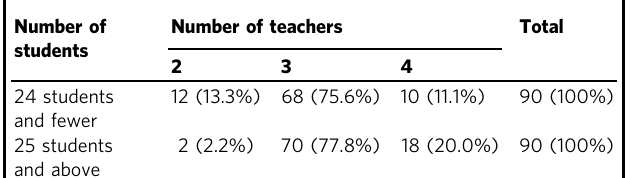
Table 4 Classroom population to number of teachers ( n = 181, missing =